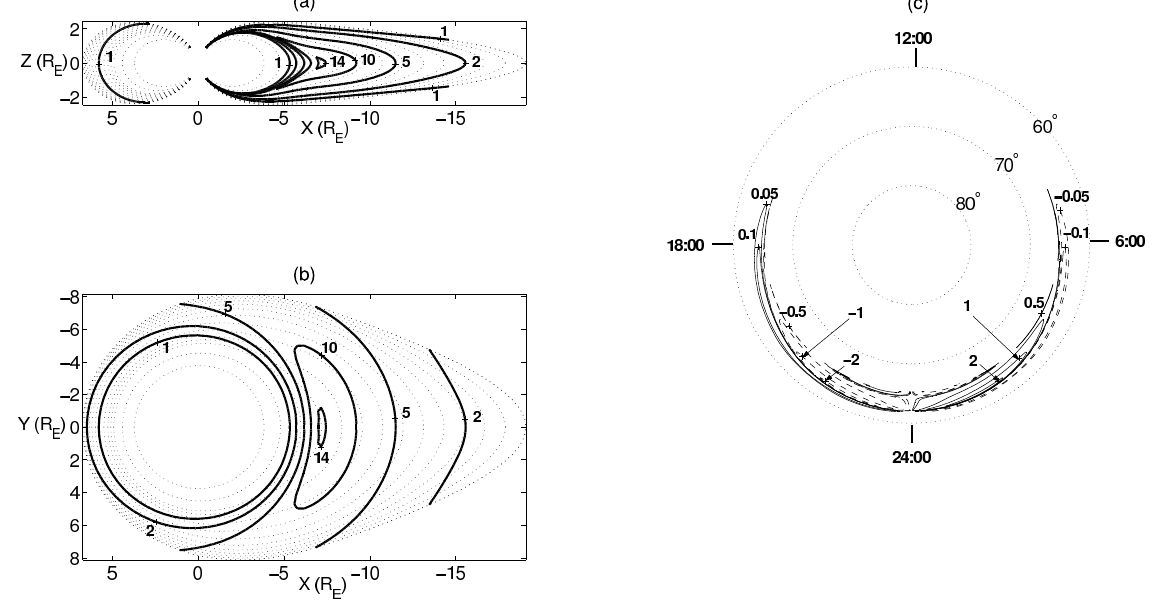
Fig. 6. Contours of constant azimuthal current density J φ in the (a) noon-midnight and (b) equatorial planes for the disturbed-time equi- librium; the dotted lines represent constant ψ contours; (c) Contours of field-aligned current density J k in the ionosphere (at 1 R E in our